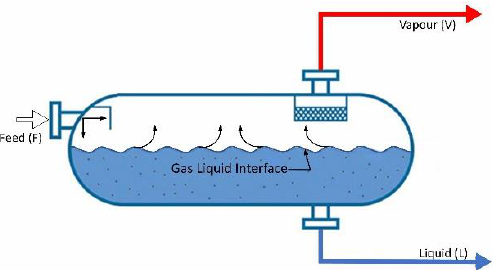
Figure 1. Schematic representation of a flash system dealing with two phases.